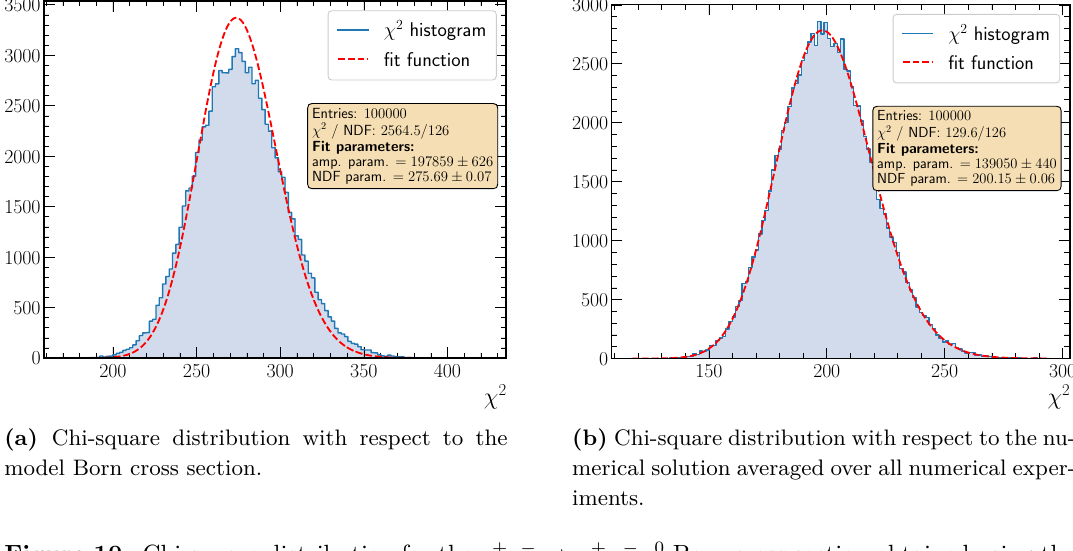
Figure 10. Chi-square distribution for the e + e − → π + π − π 0 Born cross section obtained using the naive method. The numerical solution is obtained using piecewise linear